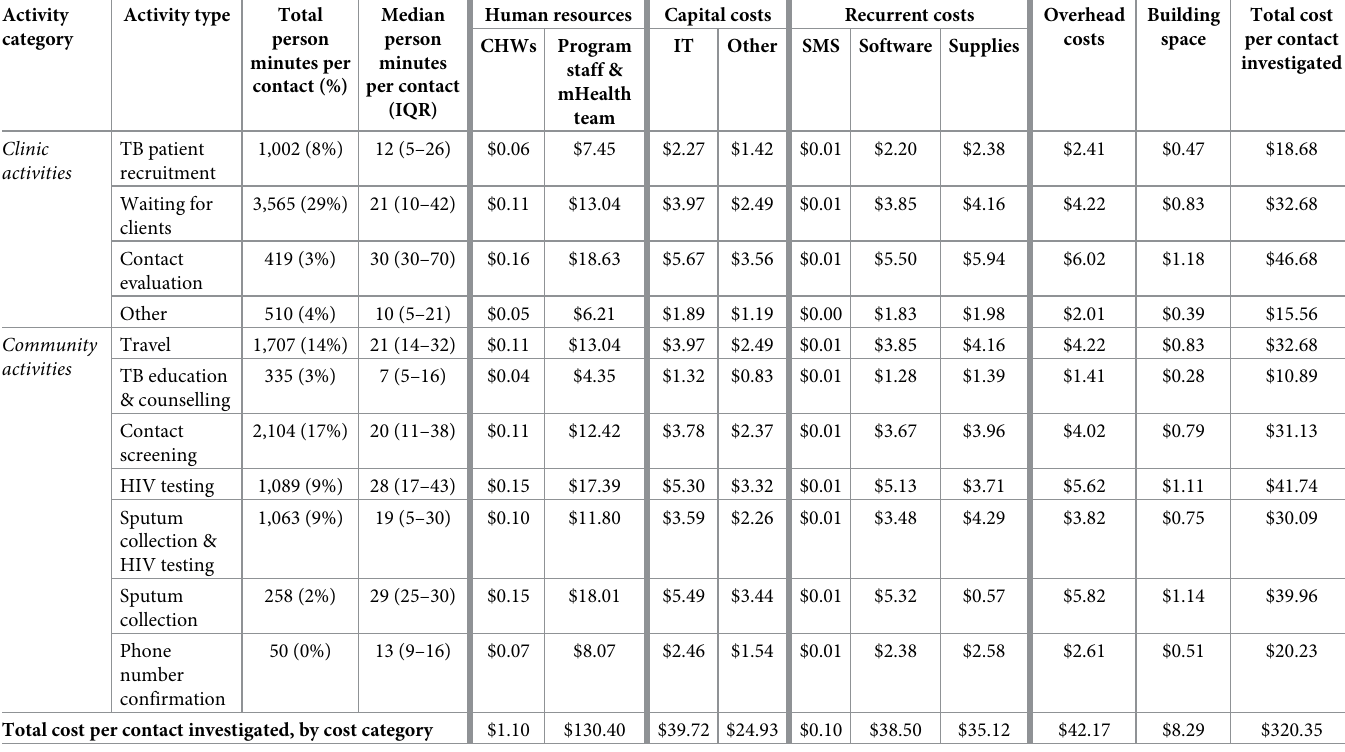
Table 3. Bottom-up unit cost estimates for each activity and resource category per household TB contact